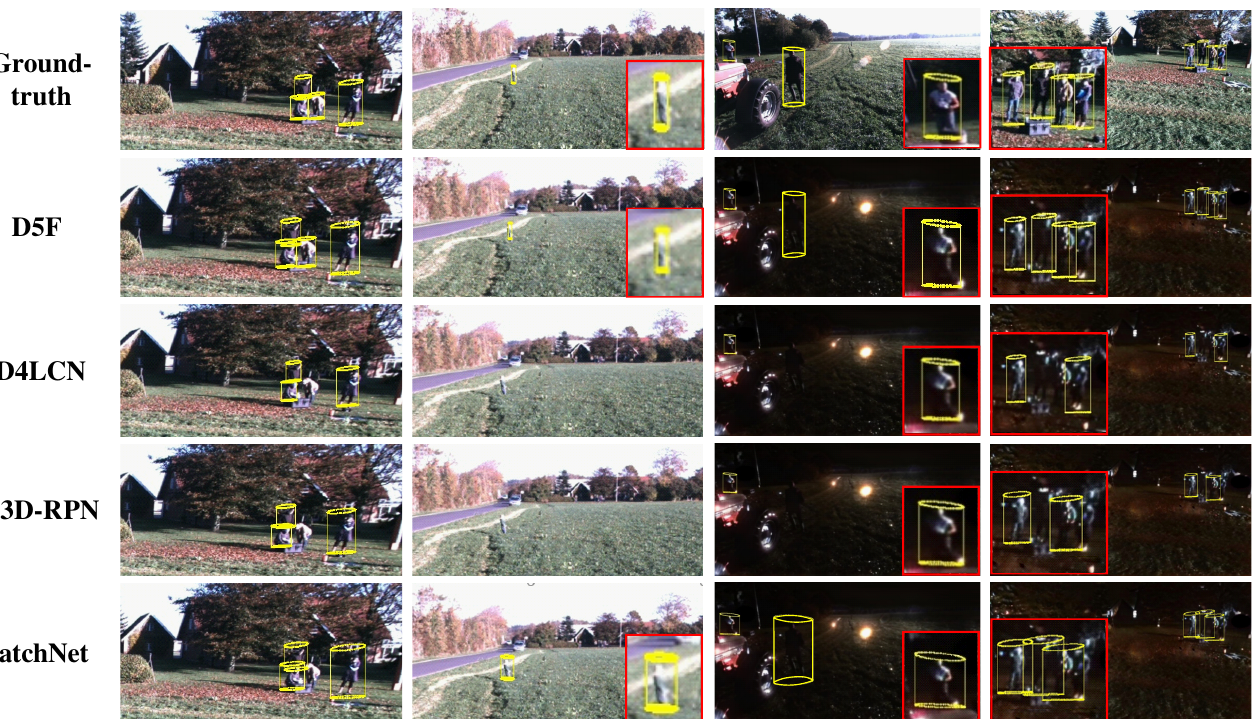
Figure 13. 3D pedestrian detection results on both daytime and nighttime images. Small objects are displayed in a zoomed red window (in the third column only the small pedestrian on the left image boundary is